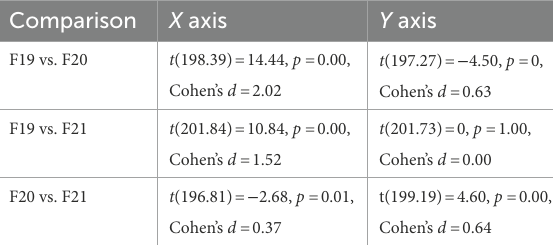
TABLE 5 Comparison networks’